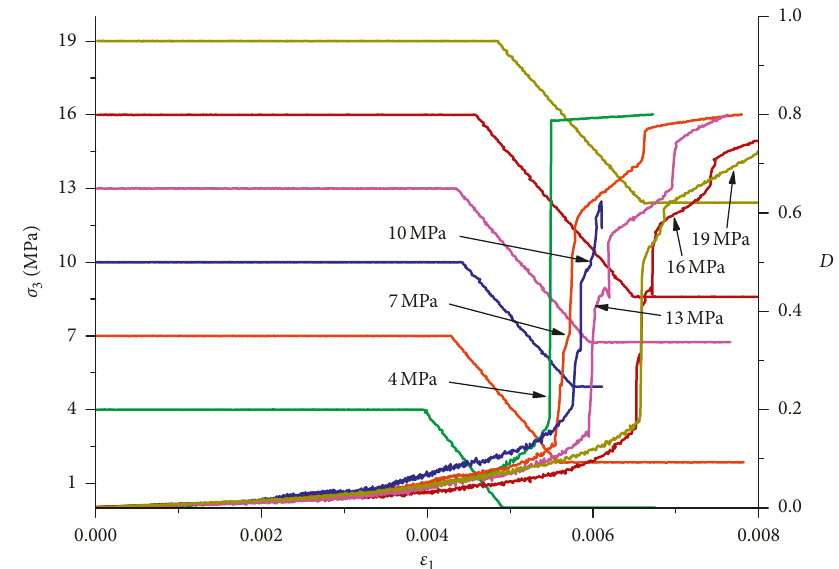
Figure 11: Damage curves of rock samples under unloading of the confining pressure based on the dissipation